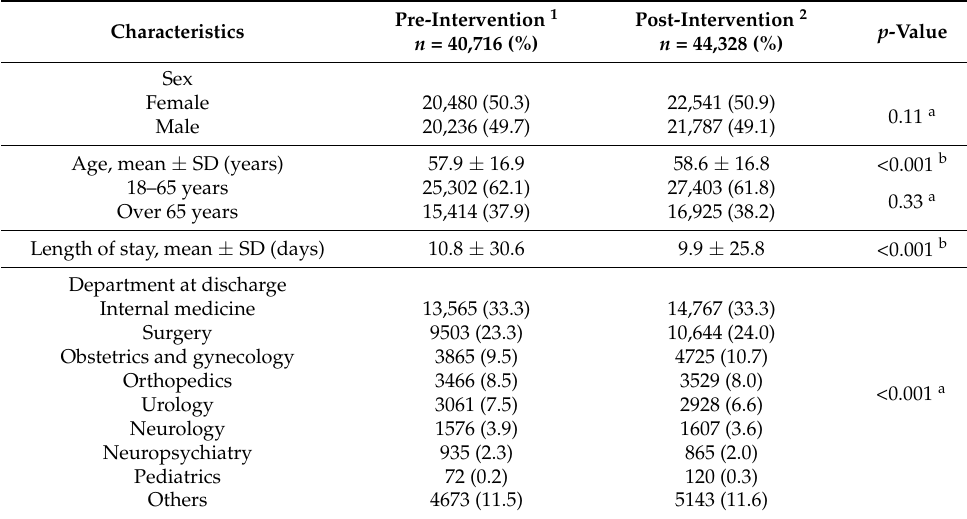
Table 2. Characteristics of the study